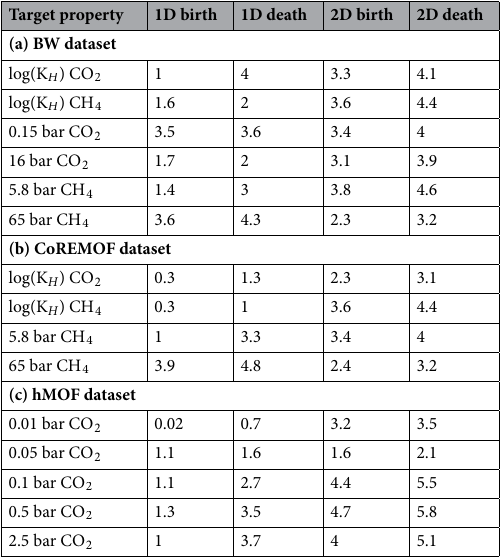
Table 4. Most important 1D/2D birth–death points for the different datasets (in Angstroms). These values correspond to the porous framework sizes most important for a given adsorption